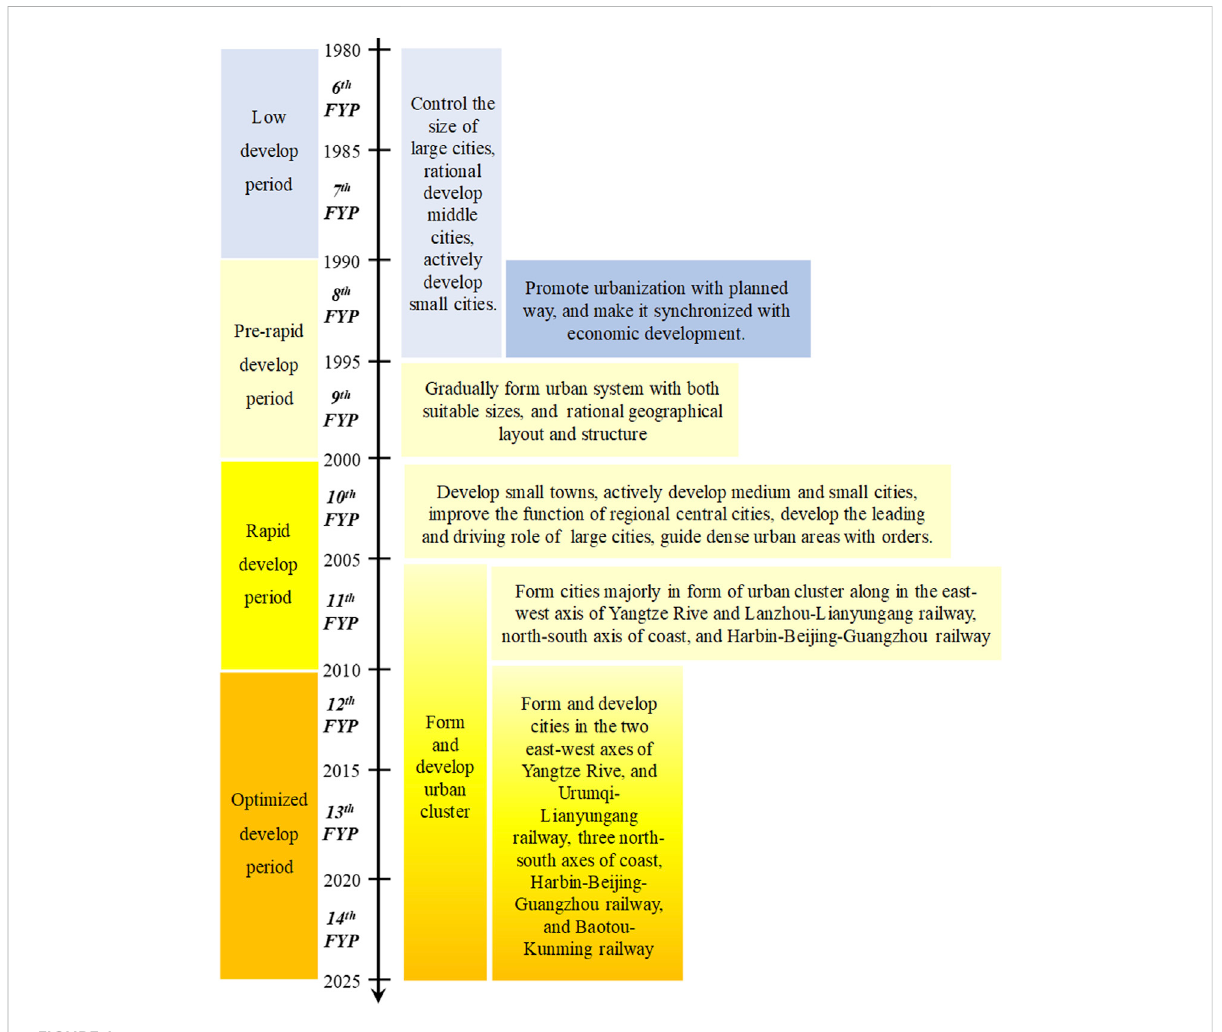
FIGURE 1 China ’ s urban developing strategy during 1980 –